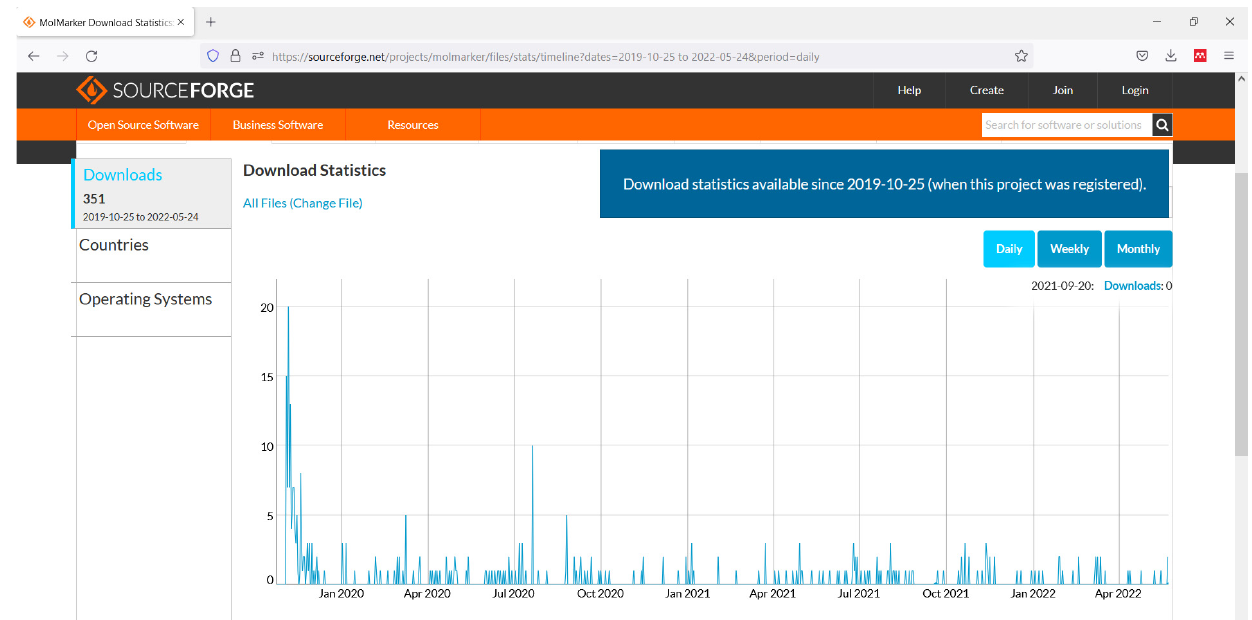
Figure 7. Download statistics for MolMarker (accessed from 25 October 2019 till 24 May 2022).